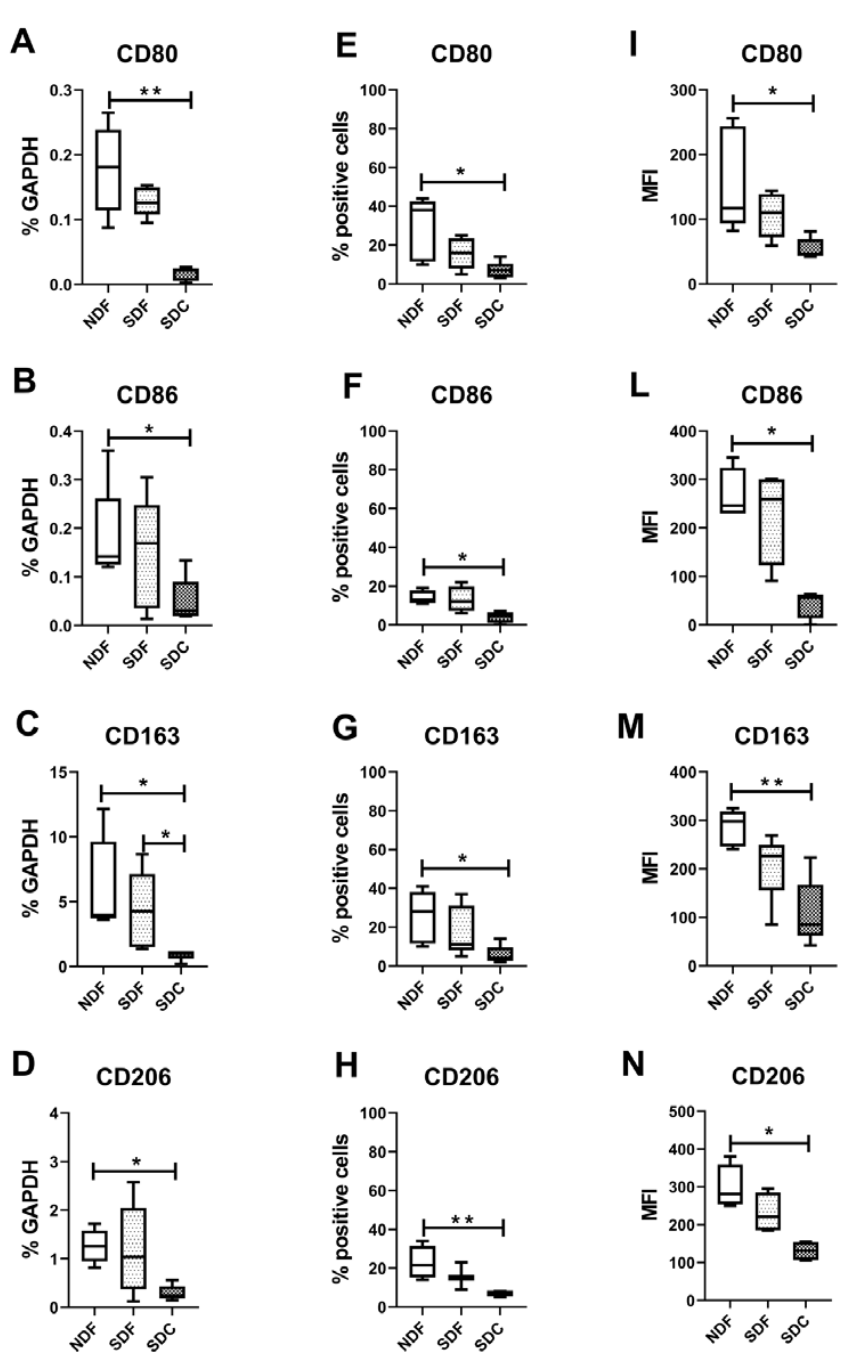
Figure 4. Evaluation of markers of synovial M1- and M2-like macrophages. CD80 ( A , E , I ), CD86 ( B , F , L ) typical markers of M1-type macrophages evaluated at both molecular ( A , B ) and protein ( E , F , I , L ) levels on cells obtained with NDF, SDF, and SDC isolation procedures ( n = 8). CD163 ( C , G , M ), CD206 ( D , H , N ) typical markers of M2-type macrophages evaluated at both molecular ( C , D ) and protein ( G , H , M , N ) levels on cells obtained with NDF, SDF, and SDC isolation procedures. Data are expressed as percentage of GAPDH (housekeeping gene) or as percentage of positive cells, or as mean fluorescent intensity (MFI), and represented as box plots with median, minimum and maximum. Significant results among groups (* p < 0.05, ** p < 0.01) were reported (Dunn’s for multiple comparisons